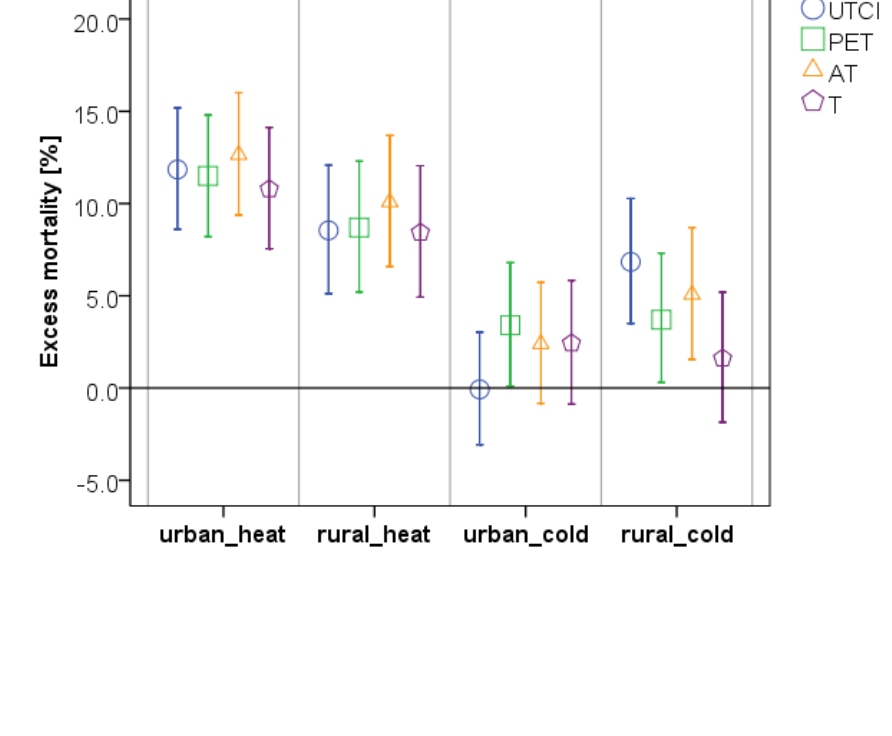
Figure 2. Mean relative excess CVD mortality (% above the expected value) for warm and cold days as determined by individual indices in the urban versus rural region. Error bars represent the 95% CI (specific values are given in Tables 2 and